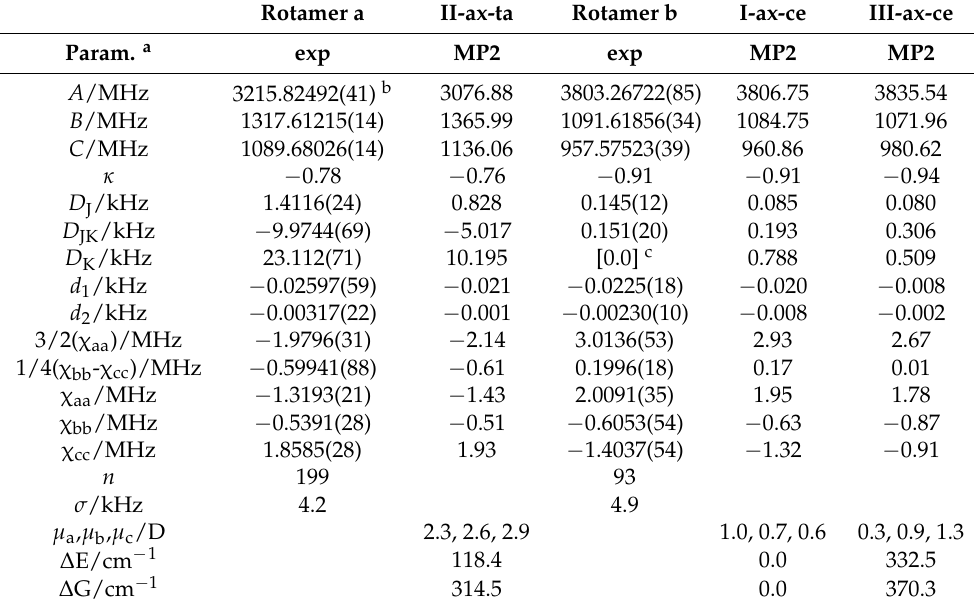
Table 1. Experimental rotational parameters for the observed rotamers of thioproline and its com- parison to the predicted MP2/6-311++G(2d,p) values (see Figure 1). The predicted electric dipole moment components and relative Gibbs energies are also